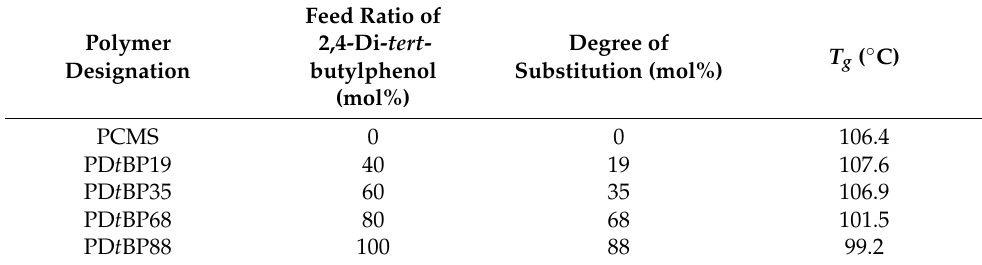
Figure 1. Synthetic route of 2,4-di- tert -butylphenoxymethyl modified polystyrene (PD t BP#), where # indicates the mole percent of 2,4-di- tert -butylphenoxymethyl containing monomeric units in the polymer. Table 1. Reaction conditions and results for the synthesis of PD t